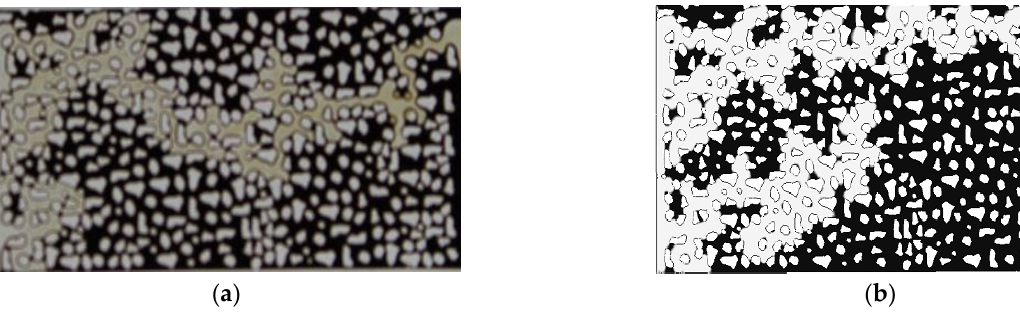
Figure 7. Flow distribution within the micromodel at rupture time. Injection velocity: 10 ft/day and IFT 2.7 mN/m. ( a ) Experimental and ( b ) simulation.